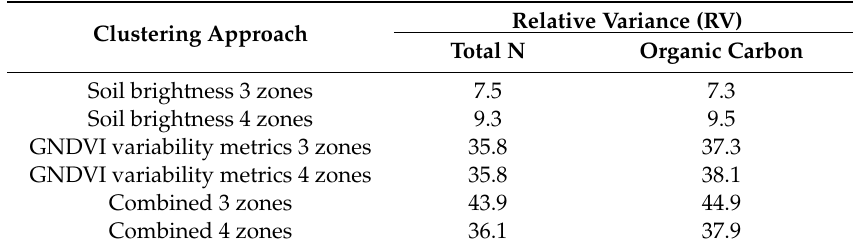
Table 1. Relative variance of measured soil variables total N and organic carbon at the field scale for three and four cluster solutions using (i) soil brightness; (ii) the spatial and temporal variability in GNDVI and (iii) a combination of